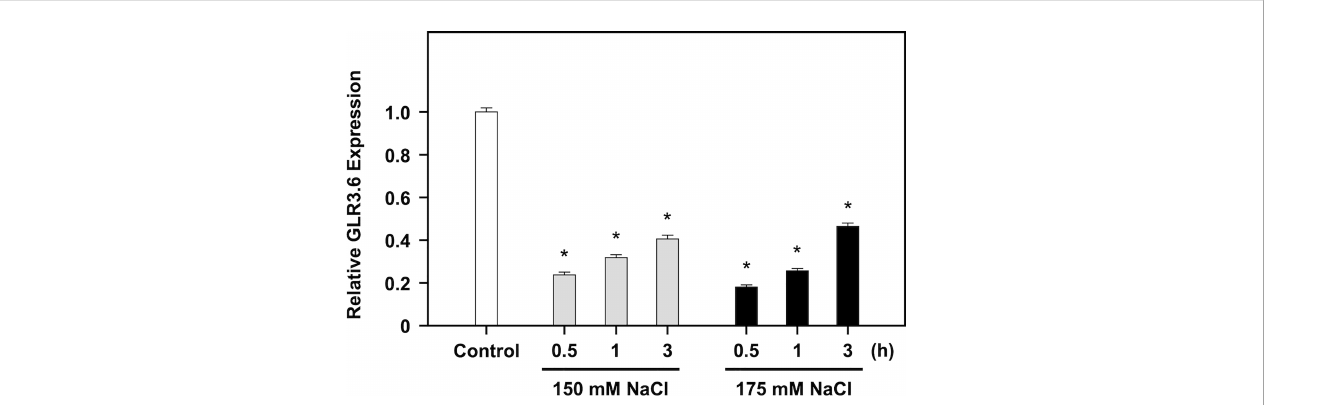
FIGURE 7 Negative regulation of GLR3.6 expressions on salt treatment. Seven-day-old seedlings were treated without or with 150 mM and 175 mM NaCl for 0.5, 1, and 3 h, respectively. The transcription level of GLR3.6 was analyzed using q-PCR. The fold change expression level was normalized relative to that of the control. The data are presented as mean values ± SD. N = 3. The asterisks indicate signi fi cant differences between samples ( P < 0.05, student ’ s t test). ACTIN2 was used as the input control for transcript level